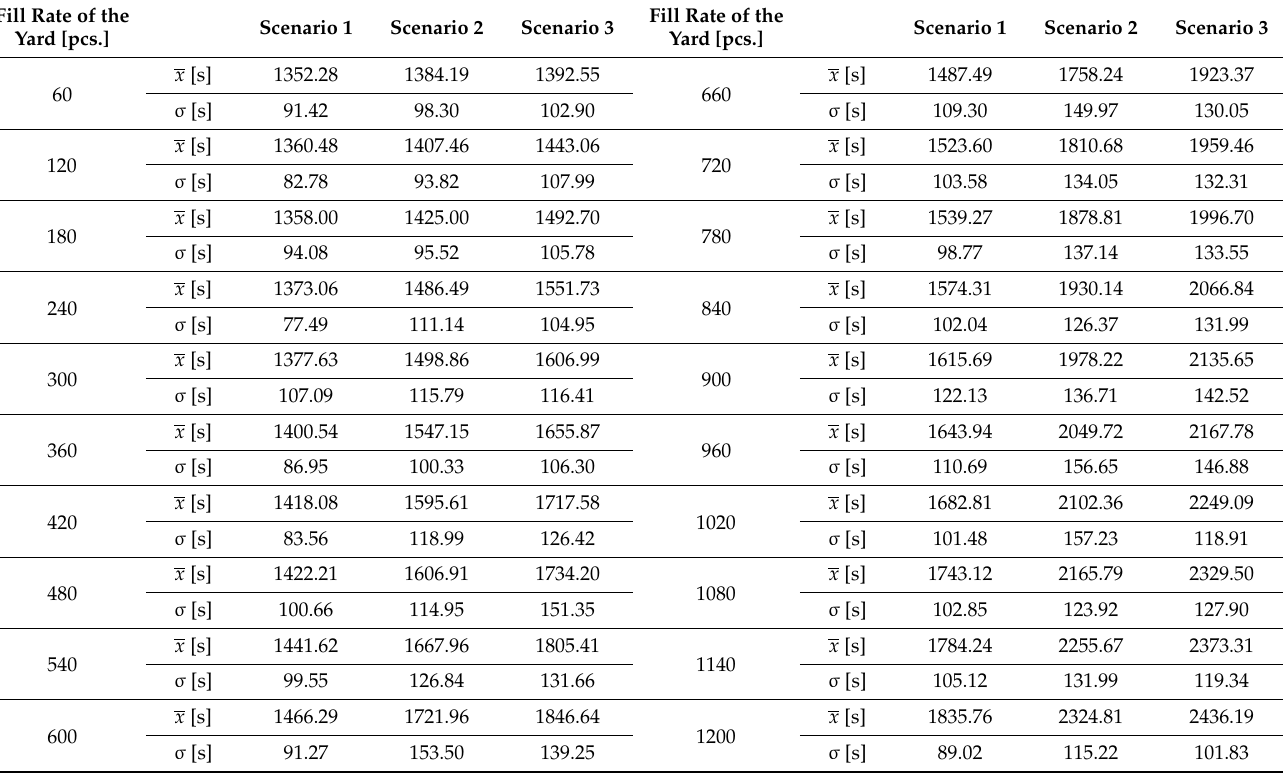
Table 2. Mean values of times and deviations for the analyzed reloading